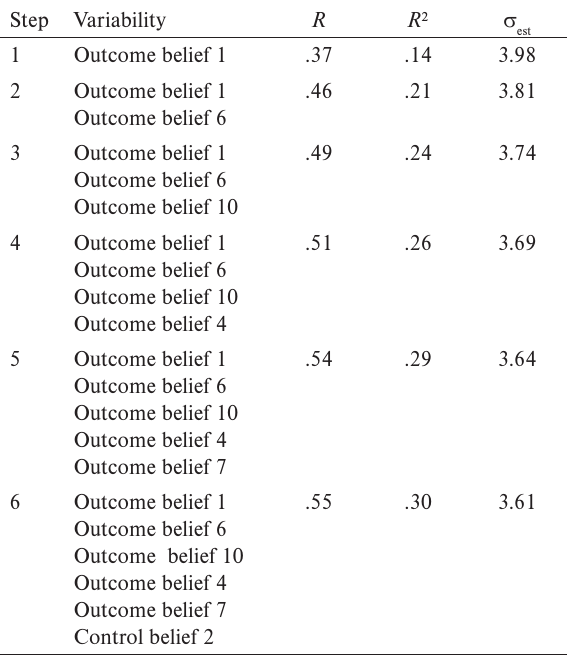
Prediction of intention using multiple regression